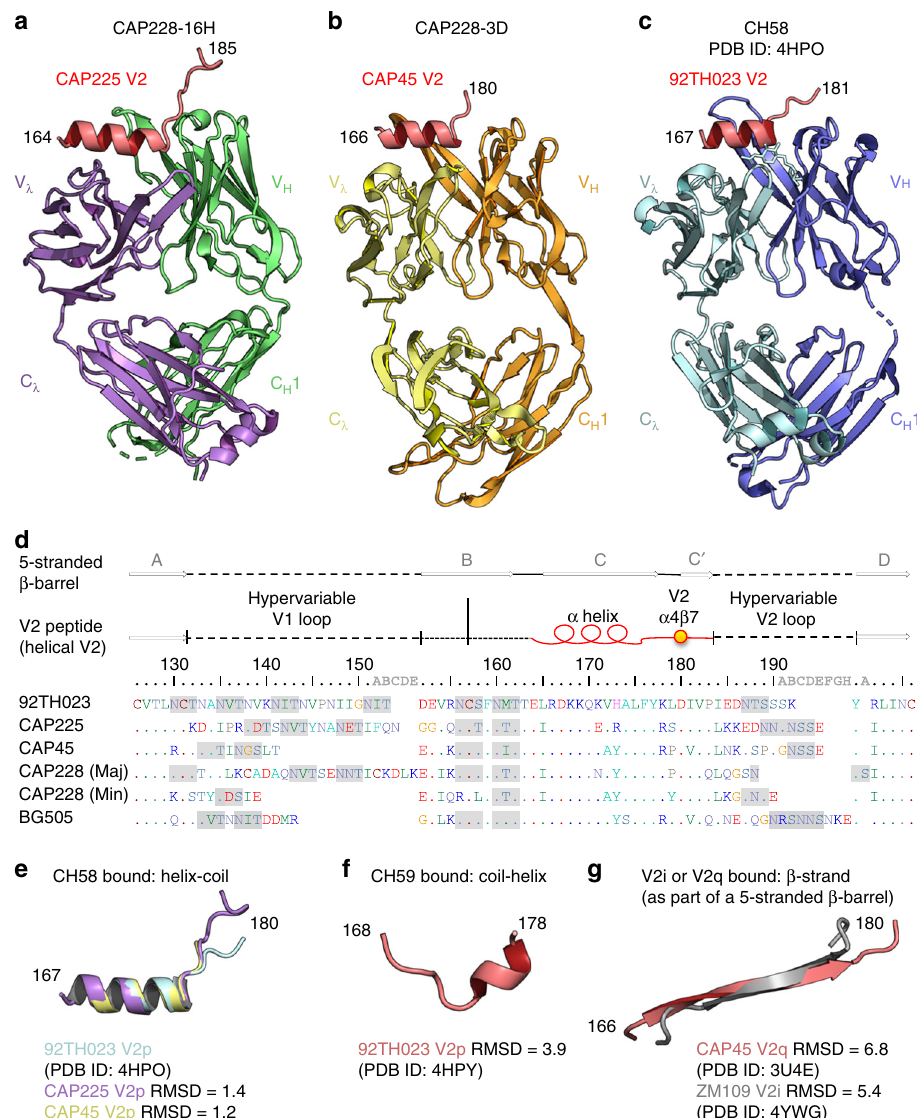
Fig. 1 HIV-1 V2 peptides reproducibly sample the same helix-coil conformation. a A cartoon representation of the Fab region from V2p mAb CAP228-16H bound to a heterologous V1V2 domain from HIV-1 strain CAP225. Only V2 residues 164 – 185 were resolved, and are shown in red. The Fab heavy and light chains are coloured green and purple, respectively. b A cartoon representation of the Fab region from V2p mAb CAP228-3D bound to a short, heterologous V2 peptide (shown in red) from HIV-1 strain CAP45. The Fab heavy and light chains are coloured orange and yellow, respectively. c Previously determined cocrystal structure of CH58 bound to the RV144 vaccine strain V2 peptide. d A sequence alignment of the V1V2 domains from the HIV-1 strains for which crystal structures were determined in this study, as well as the dominant (Maj) and subdominant (Min) CAP228 cofounder viruses. The hypervariable loop regions of V1 and V2 are indicated with the dashed lines, while the conserved V2 helix-coil motif is labelled with a red cartoon representation. A gold sphere was used to mark the location of the primary α 4 β 7 binding site, and any potential N-linked glycosylation sites are shaded grey. Above, arrows designate those regions of V1V2 that form the 5-stranded β -barrel bound by V2q/V2i mAbs. e Main chain superimposition of the V2 peptides (residues 167 – 180) bound by CAP228-16H (purple), CAP228-3D (yellow) and CH58 (light blue). The C α root-mean-square deviation for each comparison with CH58 bound peptide is shown. f Previously determined structure of a CH59 bound V2 peptide (residues 168 – 178). g Previously determined structures of the V2 C-sheet in the context of the 5-stranded β -barrel (residues 166 – 180) when bound by PG9 (red) or 830 A antigenic form of V1V2. In the context of native gp120, the V1V2 immunotype, and may represent an anti-viral function that is unique to V2p antibodies.